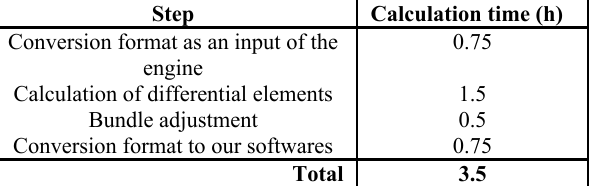
Table 2: Evaluation of the calculation time of the global block Nevertheless, lots of source code parts still have to be improved: for example, the calculation tool does not allow multi-processing